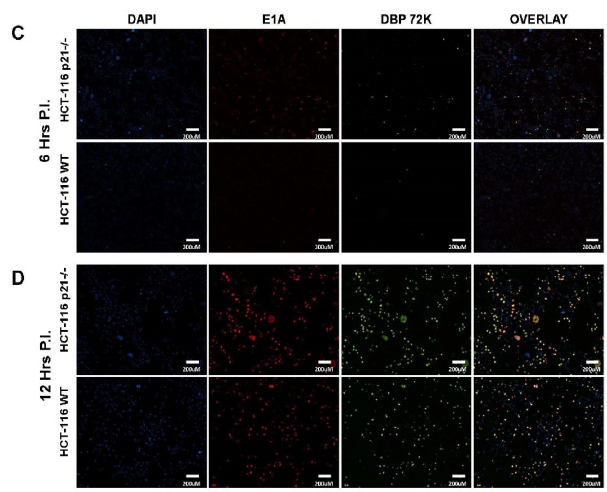
Figure 2. DBP foci formation in infected cells. HCT-116 WT and p21 − / − were plated in chamber slides and cells were infected with 5 MOI of CN702 virus. Infected cells were stopped at indicated time points and immunofluoresence microscopy was performed ( A ) 6 h p.i. 60 × representatives of DBP IF at the same time point indicative of centers of viral DNA replication. 6 h p.i. 40 × Field representatives of DBP (green) and E1A (red) IF at the same time point ( B ). Note in HCT-116 WT has approximately 3-fold lower number of cells that are both E1A and DBP positive for the same time point than HCT-116 p21 − / − cells. 6 h p.i. DBP (green) and E1A (red) IF at the same time point. Note in HCT-116 WT fewer cells are both E1A and DBP positive than HCT-116 p21 − / − cells ( C ). 12 h p.i. representative images. Note similar amount of dual stained cells shows no statistical significant difference in infectivity at later time point ( p value > 0.05) ( D